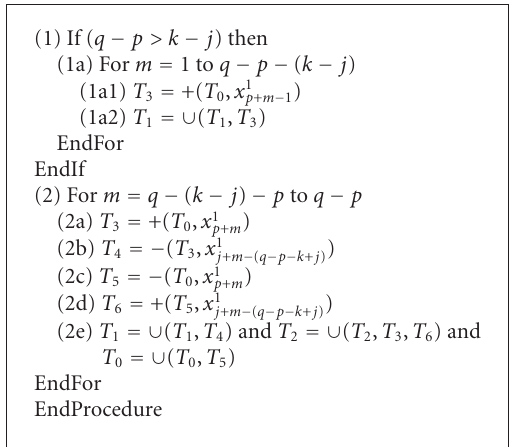
Algorithm 2: Procedure ParallelComparator ( T 0 , p , q , j , k , T 1 , T 2